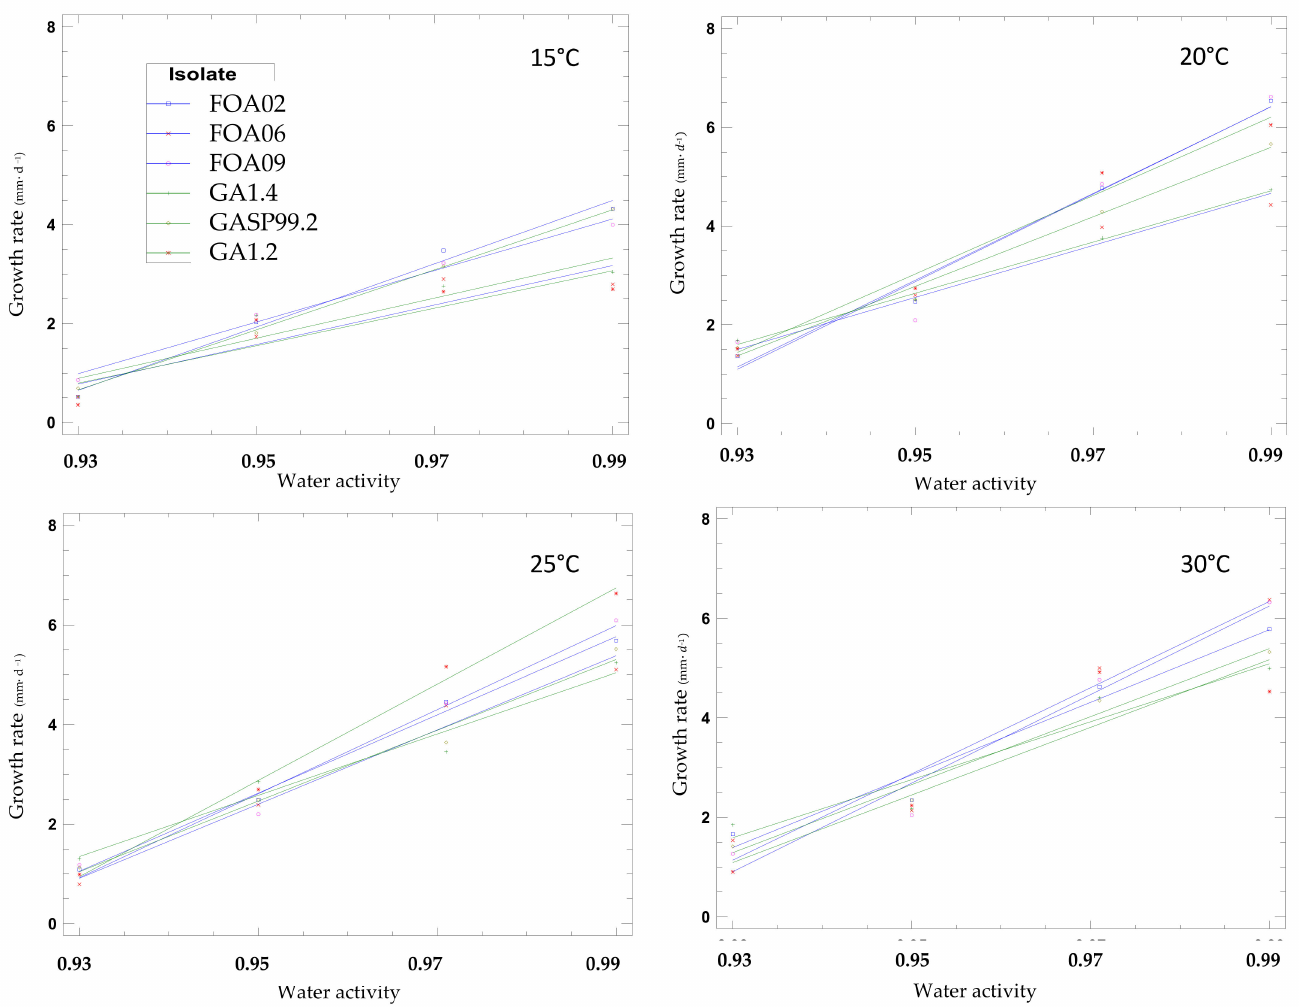
Figure 4. Growth rate of the different isolates of F. oxysporum from Poland ( green line ) and Spain ( blue line ) analysed at the different temperatures and water activities